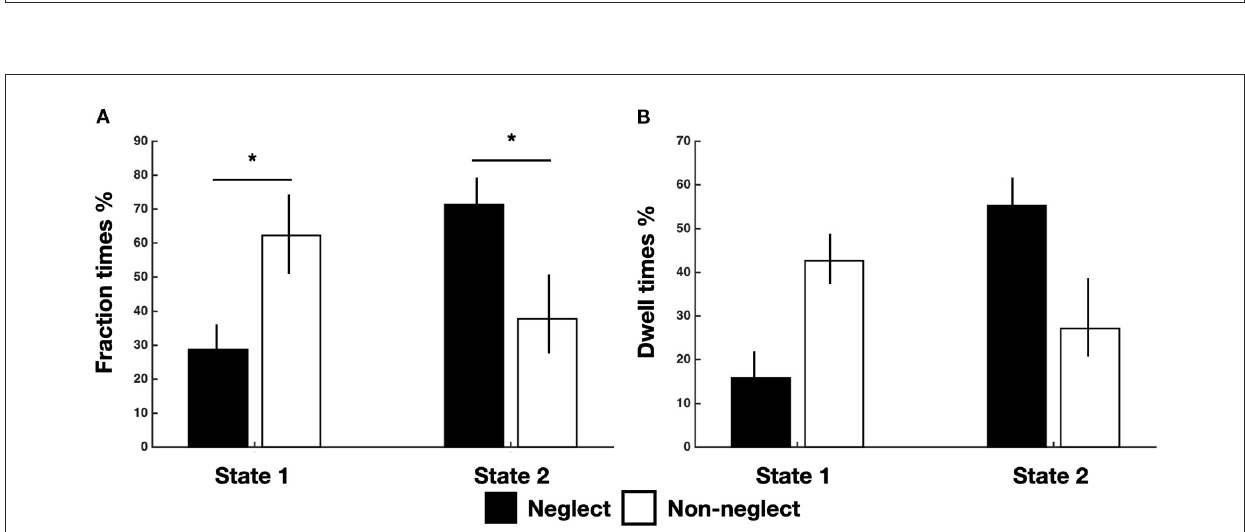
FIGURE2 Temporal properties of brain states for neglect and non-neglect patients. Bar graphs indicate fraction (A) and dwell (B) times of each state for neglect (black) and non-neglect (white) patients, respectively. * p < 0.05,